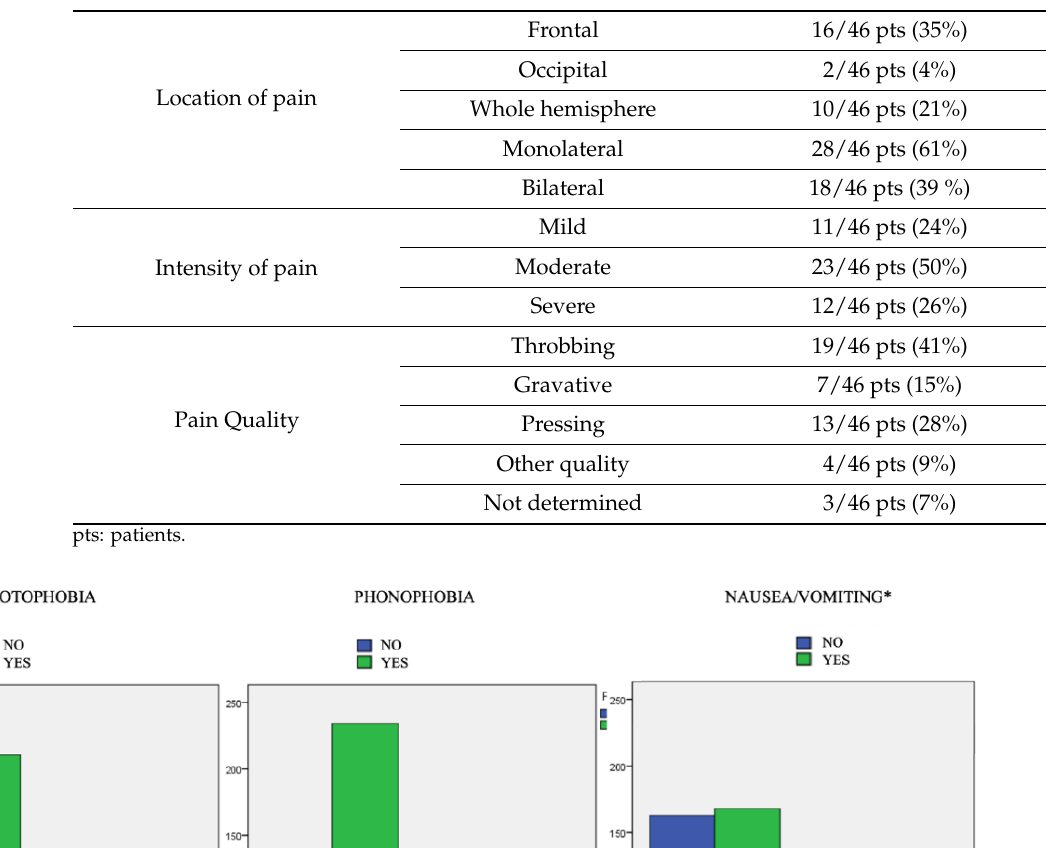
Table 1. Location, quality, and intensity of pain in paediatric patients with NDPH.